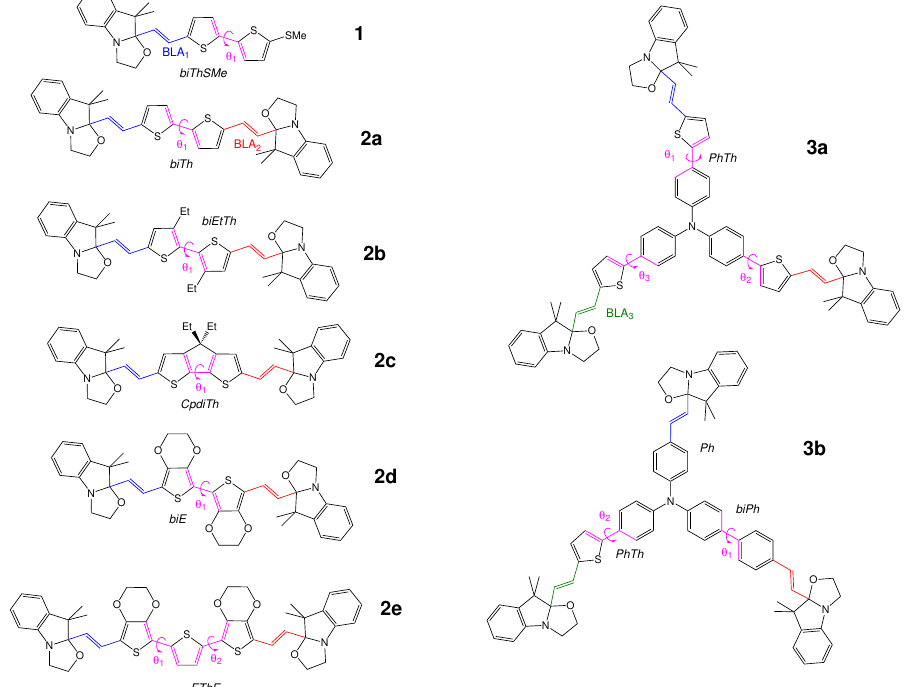
Figure 3. Structure of the different BOX derivatives, with the nomenclature of their π -conjugated linkers (bithiophene (biTh), biethylthiophene (biEtTh), cyclopentadithiophene (CpdiTh), bi-EDOT (biE), EDOT-thiophene-EDOT (EThE), phenyl (Ph), biphenyl (biPh), and phenylthiophene (PhTh)), as well as the definition of the different segments where the BLA and out-of-plane angles (OOPAs) are